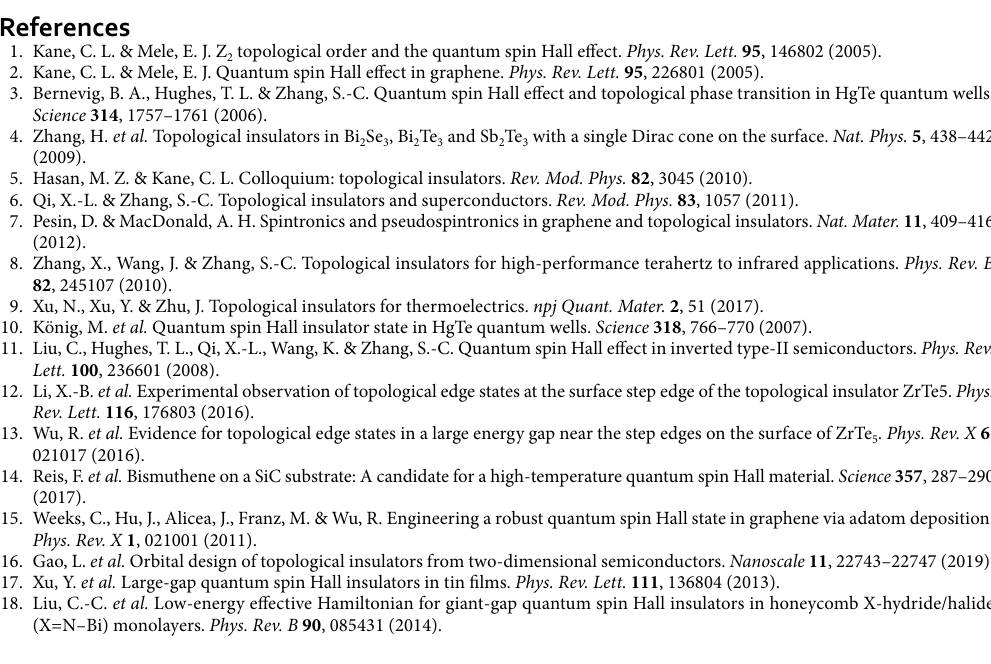
Fig. S7. In the absence of SOC, the systems with both doping patterns exhibit trivial metallic properties. In the presence of SOC, the two systems both transform into large band-gap topological insulators (with the E F moving to 0.3 eV). Similar results are obtained for the Bi and Tl cases (not shown). These obtained results indicate that the doping of Pb, Bi, or Tl atoms (decaying products) in the trigonal poloniumene does not alter the